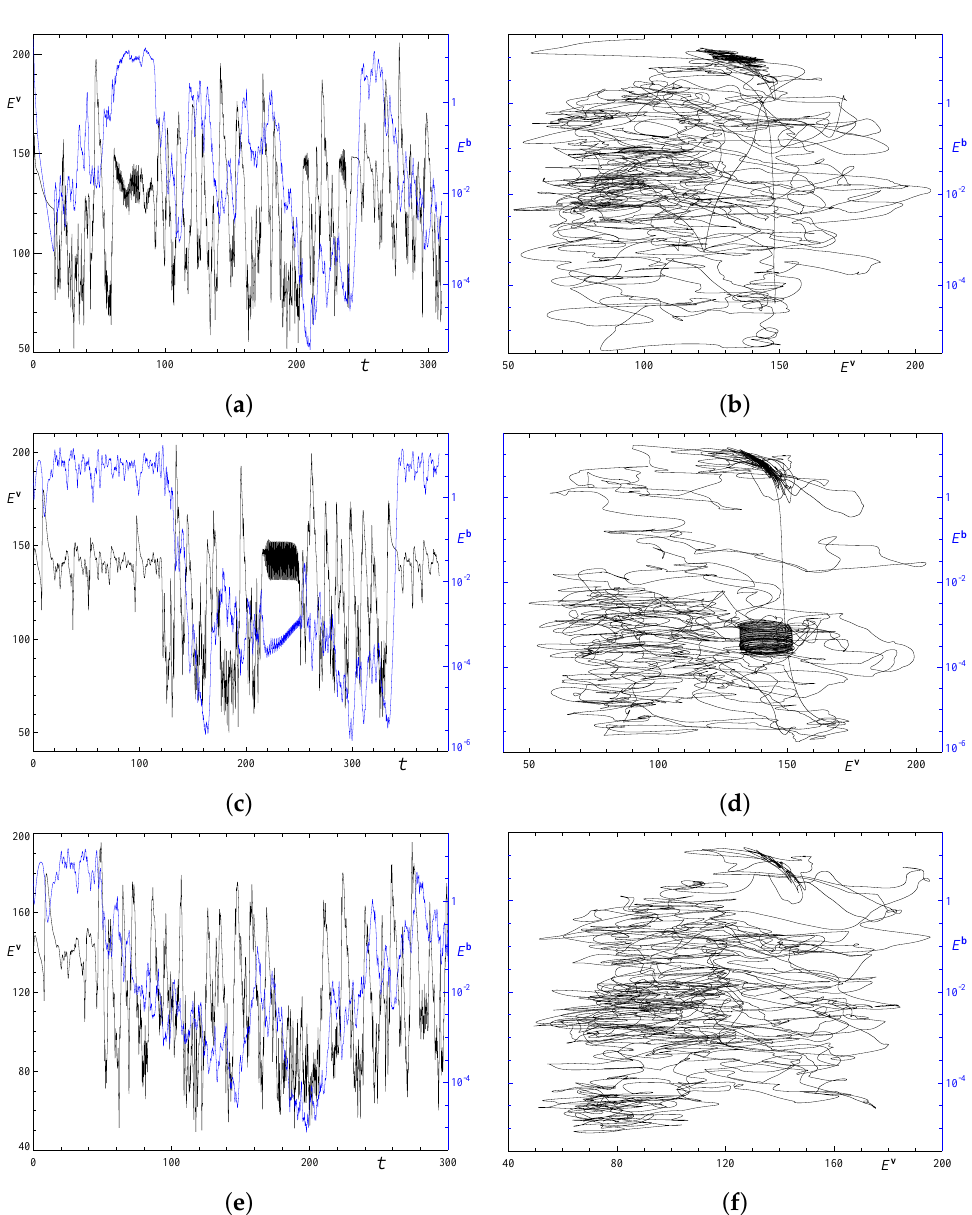
Figure 20. Temporal behaviour of the mean kinetic (left vertical axis, black line) and magnetic (right vertical axis, blue line) energies (left column), and projection of the trajectories on the plane of magnetic and kinetic energies (right column) in the quadruple-period runs 4 x 1.2 for the stan- dard resolution, (a), (b); 4 x 1.1 for the standard resolution, (c), (d); and 4 x 1.1 for the alternative resolution (e),